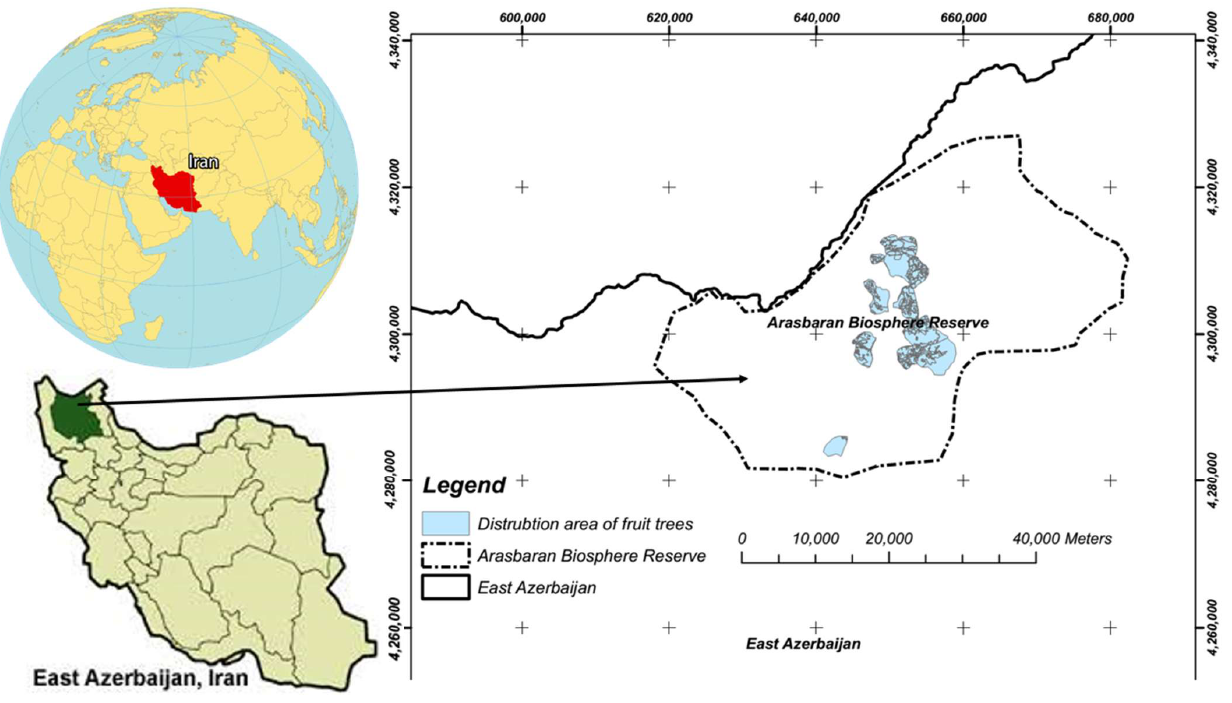
Figure 1. The location of the Arasbaran forests in the East Azerbaijan province,